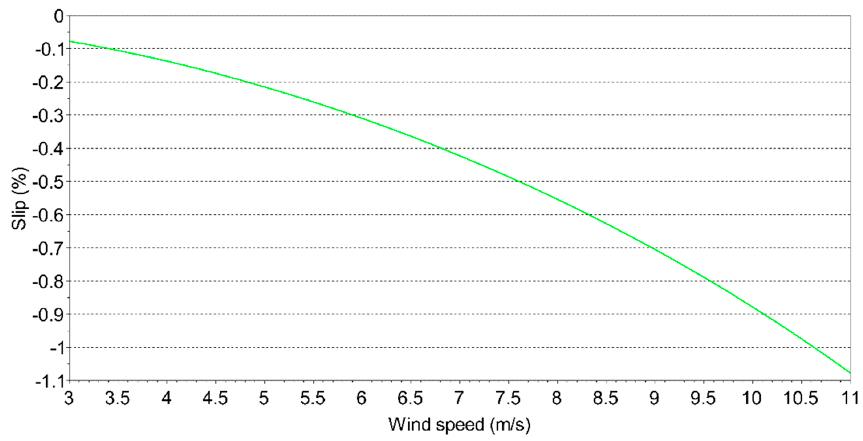
Figure 6. Induction generator slip in steady state as a function of wind speed.